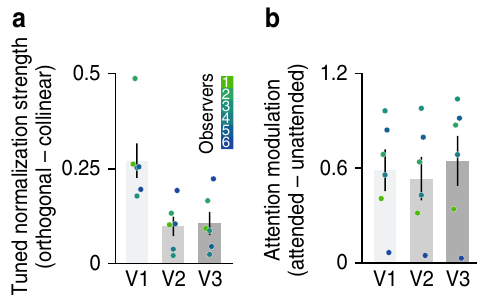
uned Fig. 3 Measures of tuned normalization strength and attention modulation. a Tuned normalization strength re fl ects the difference between BOLD responses evoked by orthogonal and collinear stimuli blocks (% signal change). The orthogonal con fi guration elicited larger BOLD responses compared with the collinear con fi guration across V1 – V3. b Attention modulation re fl ects the difference in BOLD response between attended and unattended stimuli blocks (% signal change). We Tuned normalization strength was quanti fi ed as the difference between the mean BOLD responses to orthogonal and collinear stimuli blocks. Collinear stimuli evoked weaker BOLD responses compared with orthogonal stimuli, resulting in a positive difference for all regions of interest (Fig. 3a). To measure attentional modulation, we assessed BOLD responses while participants viewed orientation bandpass- fi ltered noise gratings (outer diameter 15°; inner diameter 3°; at 50% Michelson contrast; spatial frequencies between 2 and 3 cycles/°; orientation bandwidth of 10°). While viewing these stimuli, participants were asked to either covertly attend toward the stimulus, performing a fi ne orientation discrimination task (Attended condition), or perform a demanding task at fi xation, which drew attention away from the oriented stimulus (Unattended condition). Note that the visual stimulation was identical in both conditions, with the only difference being the task observers performed (Supplementary Fig. 6). Attention modulation was de fi ned as the difference between BOLD responses to attended and unattended stimuli blocks. Consistent with previous fi ndings 24,51 – 53 , striate and extrastriate cortex exhibited robust attentional modulation (Fig. 3b; repeated measures ANOVA: main effect of attention F = 0.771, while main effect for visual (1,15) = 50.38, p < 0.001, η 2 p area and the interaction did not reach signi fi cance, p > 0.4). (Fig. 1c). Leveraging this population-wide heterogeneity in neural ization measures, our results revealed that subpopulations that attentional bene fi ts, most strongly within V1 and V3 (Fig. 4; one- way ANOVA on Fisher-Z transformed Spearman correlations; F = 0.307; post hoc two-sided one (2,17) = 3.326, p = 0.064, η 2 p sample t -tests V1: t (5) = 4.30, p = 0.0231, d = 1.76, V2: t (5) = 2.96, p = 0.0944, d = 1.21, and V3: t (5) = 5.14, p = 0.0109, d =